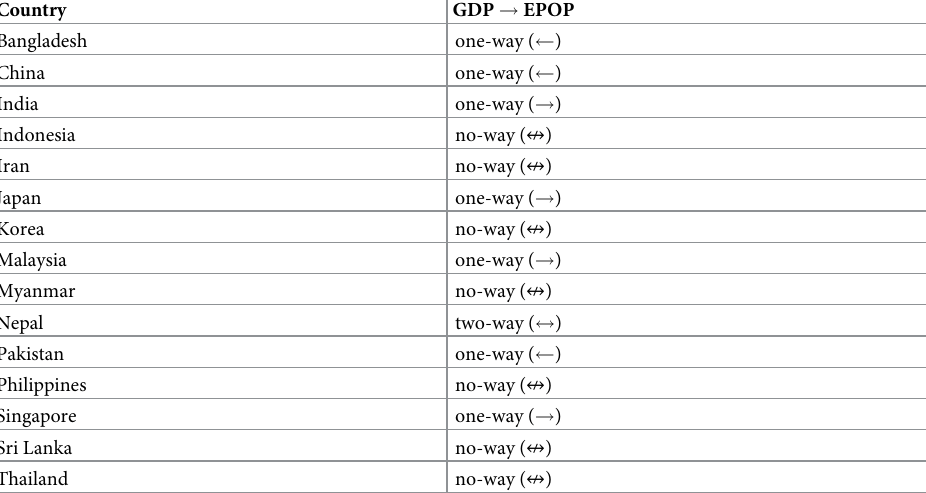
Table 3. Granger causality test